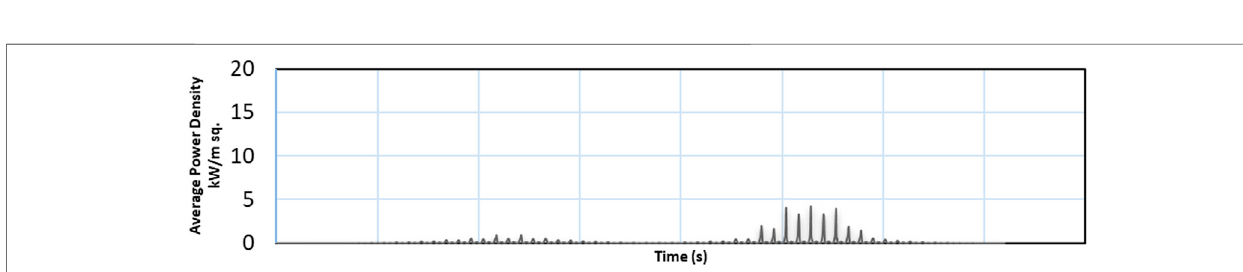
FIGURE 9 | Average power density plot of alderney race with the friction coef fi cient of 0.01.